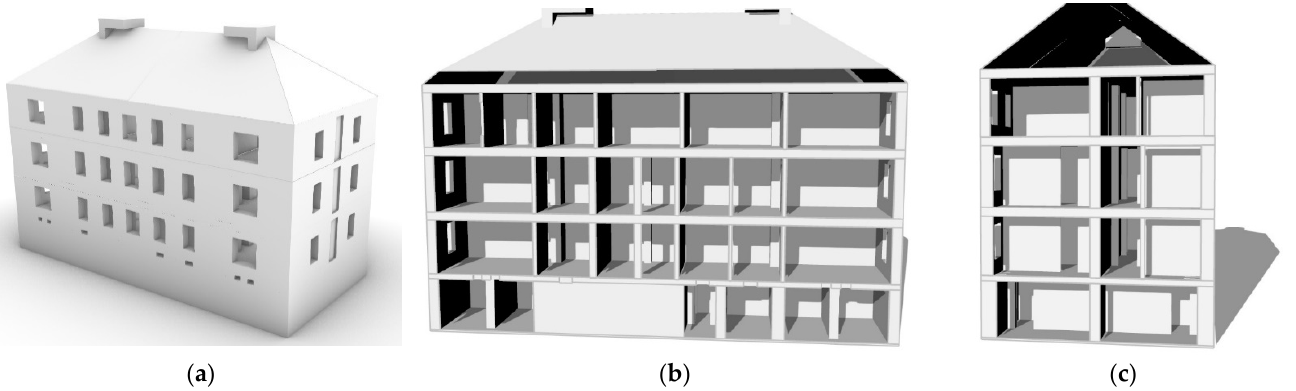
Figure 7. ( a ) Three-dimensional (3D) model; ( b ) 3D model—longitudinal cross-section; ( c ) 3D model—transversal cross- section.